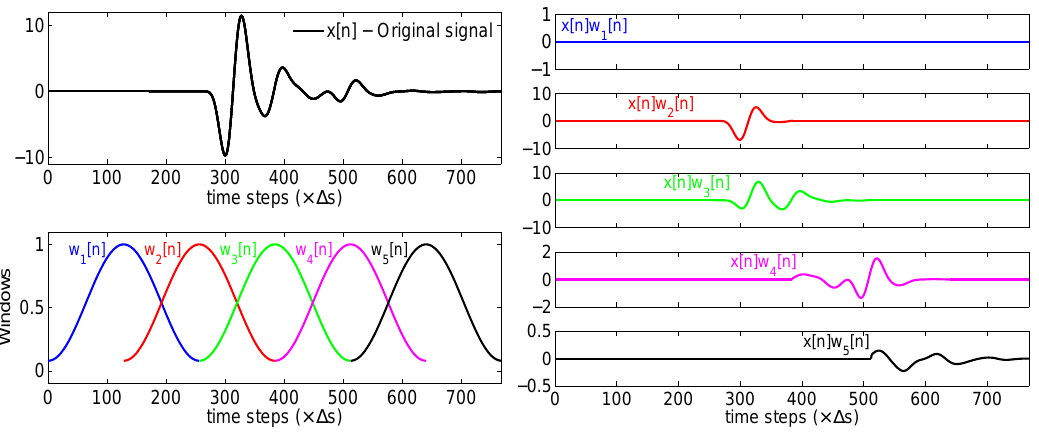
Figure 14. (Left:) One of the original received signal and the employed Hamming windows with overlapping factor of 0.5; (right:) corresponding windowed signals. Note the amplitude difference for each windowed